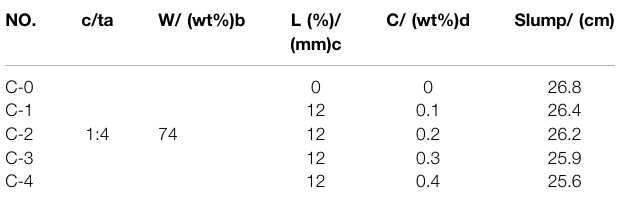
TABLE 4 | The experiment scheme design of uniaxial compressive strength tests and tension